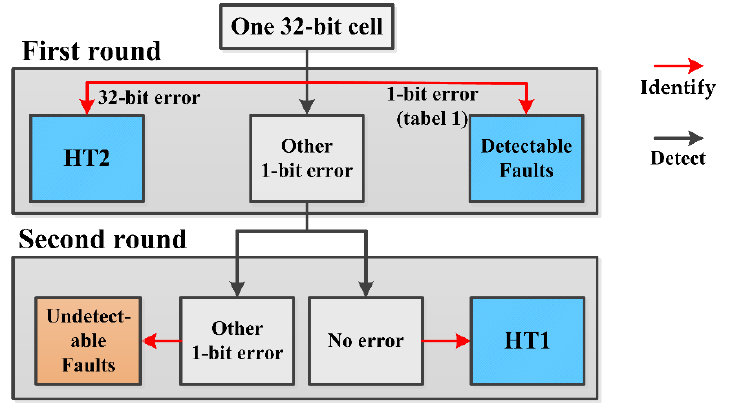
Figure 2. The diagnostic process.